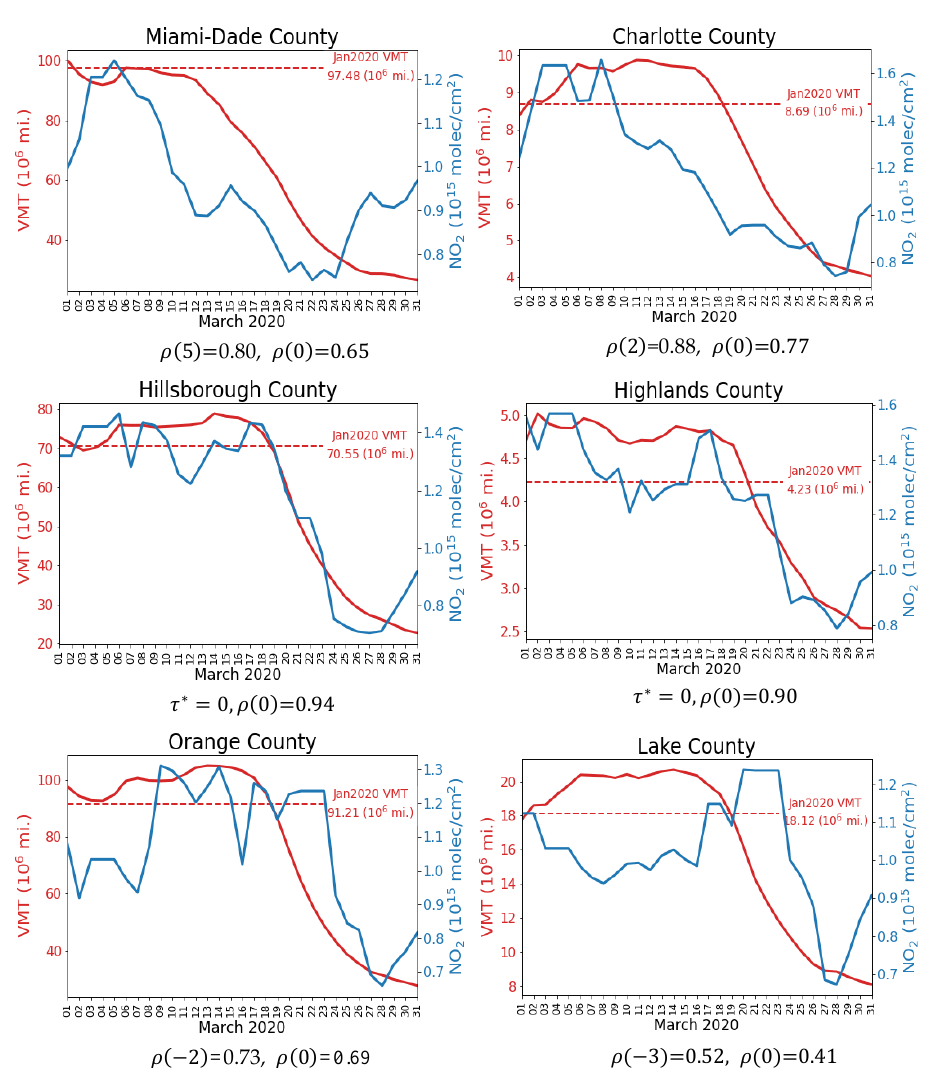
Figure 7. Di ff erent time lags ( τ ∗ ) and correlation ρ ( τ ∗ ) between 7-day moving averages of VMT and NO 2 in counties with high population density (left column < 0.5 acre per person) and low population Figure 7. Different time lags (𝜏 ∗ ) and correlation 𝜌(𝜏 ∗ ) between 7-day moving averages of VMT density (right column > 2 acre per and NO 2 in counties with high population density (left column <0.5 acre per person) and low population density (right column >2 acre per person).